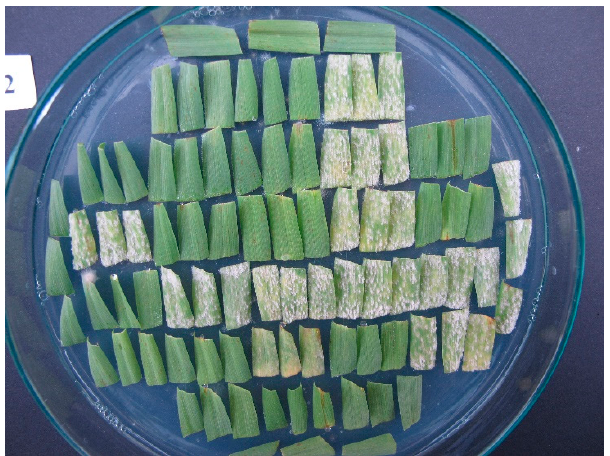
Figure 1. Infection responses (IRs) produced by a Blumeria graminis f. sp. hordei isolate on 30 barley genotypes each represented with a triplet of leaf segments seven days after inoculation; three IRs are shown here, IR 0—full resistance (green leaf segments), IR 4—full susceptibility (leaf segments with colonies of white conidia of the pathogen) and IR 2 — moderate resistance (colonies of grey mycelium surrounded with chlorotic/necrotic spots) on a triplet in the middle of the last long row. This figure is a demonstration picture from other tests.